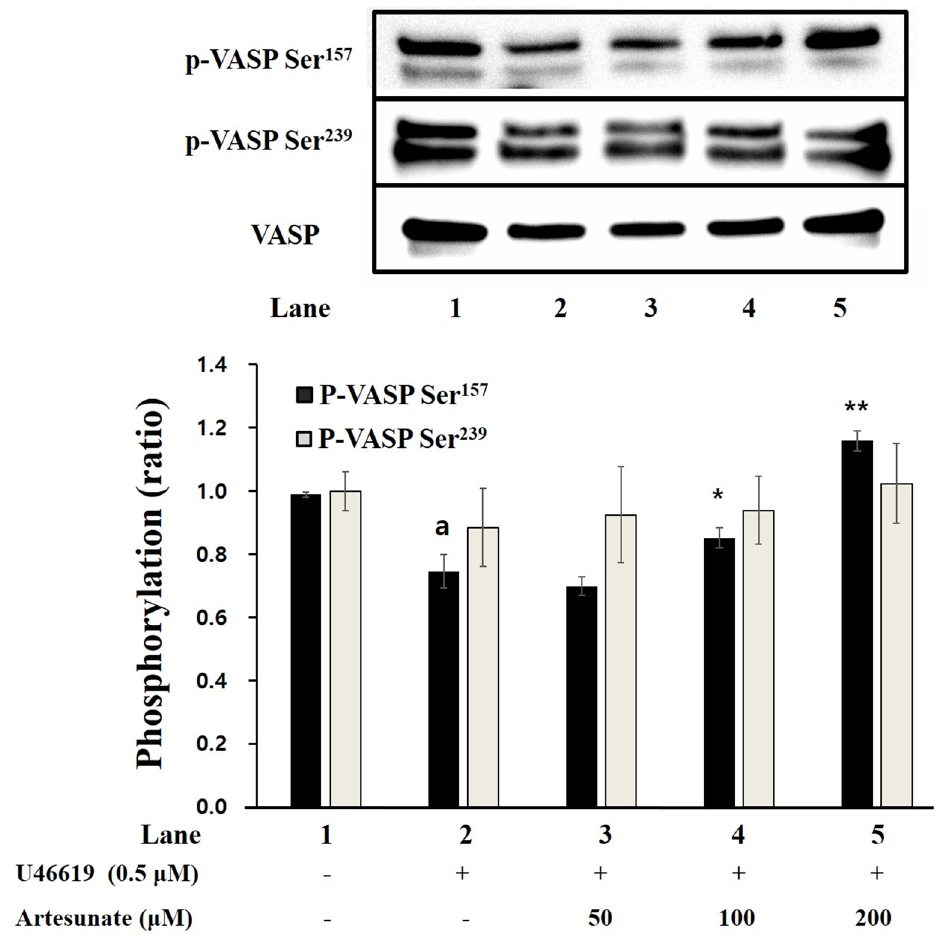
Figure 4. Artesunate’s effect on VASP phosphorylation. Termination of the reaction was carried out using a 1 × lysis buffer. A BCA protein kit measured protein concentration from platelet lysates. Isolated protein (20 µ g) from 4–20% SDS–PAGE was transferred to the PVDF membrane. The primary antibody was treated with a dilution factor of 1:1000 and the secondary antibody was treated with a dilution factor of 1:2000. The results are shown as mean ± SD ( n = 4). a p < 0.05 in comparison to non–stimulated platelets, * p < 0.05, ** p < 0.001 in comparison to the U46619–induced platelets.